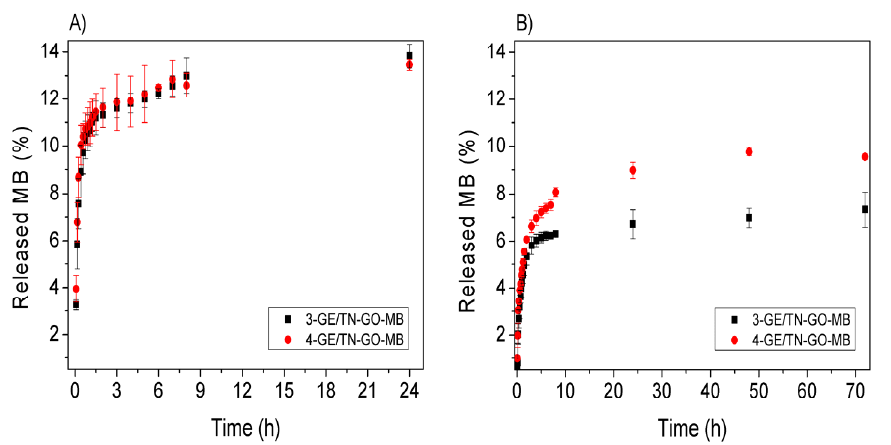
Figure 9. Release kinetics studies of MB from the GE/TN-GO-MB hydrogels: ( A ) SGF and ( B ) SIF. In SGF, dried hydrogels released low MB contents, achieving between 13.82% (17.96 × 10 − 3 mg/mL) and 13.45% ( ± 1.22%) (16.14 × 10 − 3 mg/mL) for 3-GE/TN- GO-MB and 4-GE/TN-GO-MB hydrogels, respectively. The SIF released 7.33% ( ± 0.74) (9.53 × 10 − 3 mg/mL) and 9.54% ( ± 0.13) (11.44 × 10 − 3 mg/mL) for the 3-GE/TN-GO-MB and 4-GE/TN-GO-MB hydrogels,